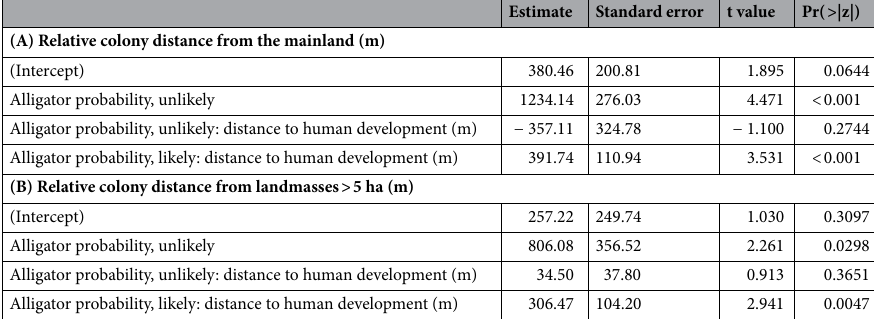
Table 1. Results of the best GLMM in each set assessing effect of alligator probability and alternative methods of protection on (A) relative colony distance from the mainland (meters) and (B) relative colony distance from landmasses > 5 ha (meters). Model includes associated colony as a random factor. All continuous variables were scaled.